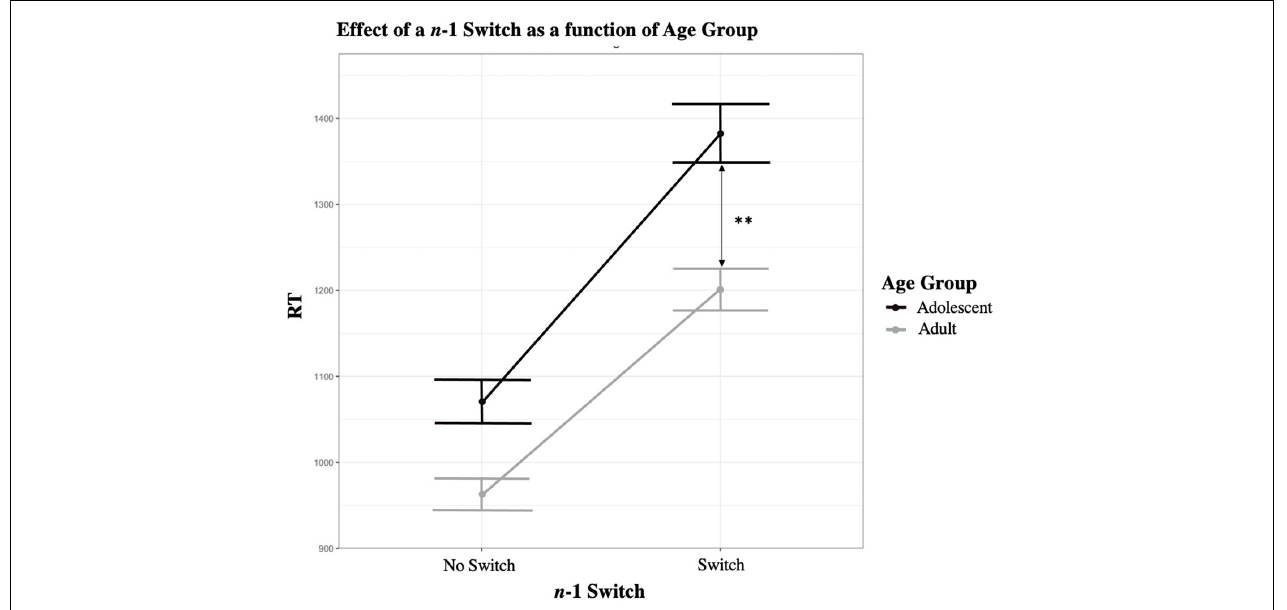
FIGURE 1 | Effect of a n -1 Switch as a function of age group. Graphical representation of the n -1 Switch × Age interaction. The difference in RT when there is a n -1 Switch versus no switch is significantly greater in adolescents versus adults. * p < 0.05, ** p < 0.01, *** p <